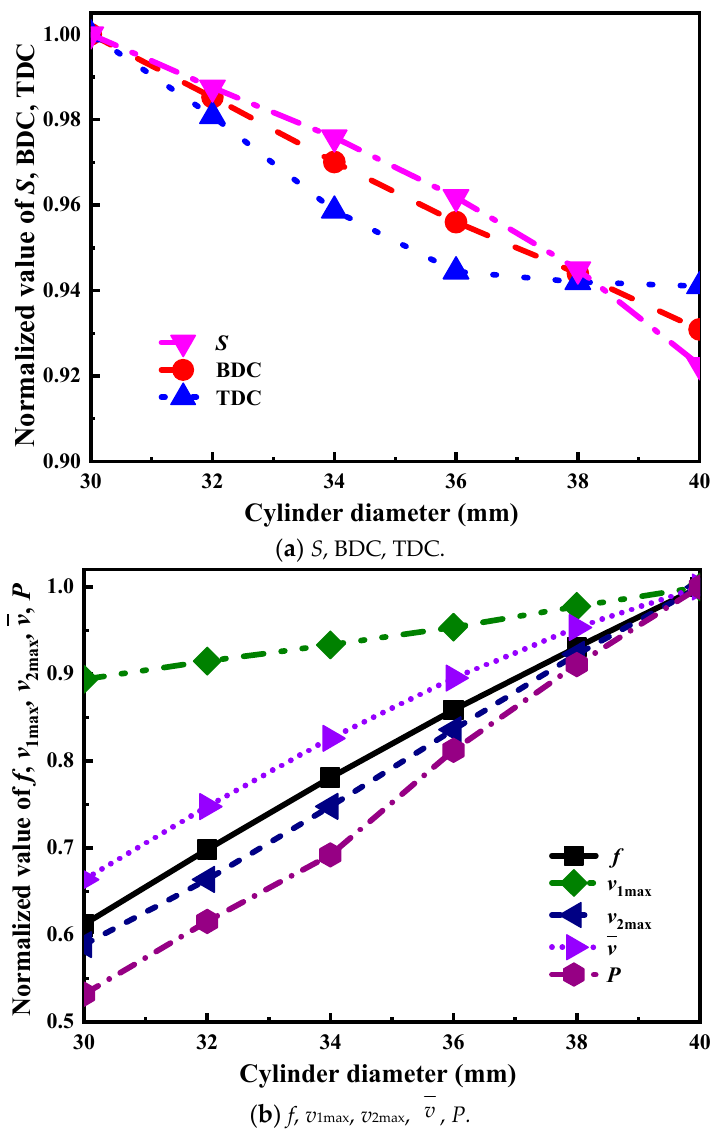
Figure 9. Variation of performance parameters with cylinder diameter.